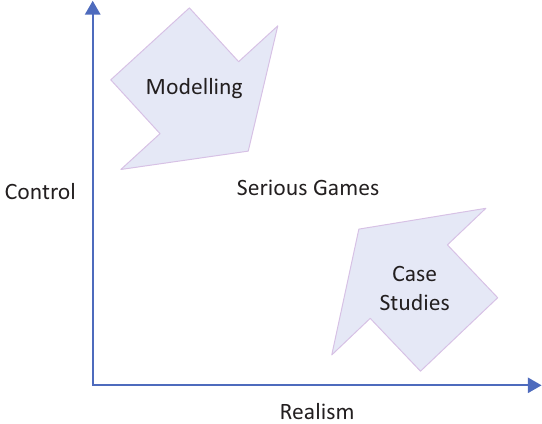
Figure 1. Gaming methods related to other methods in engineering research. Source: Authors’ work based on Grogan and Meijer